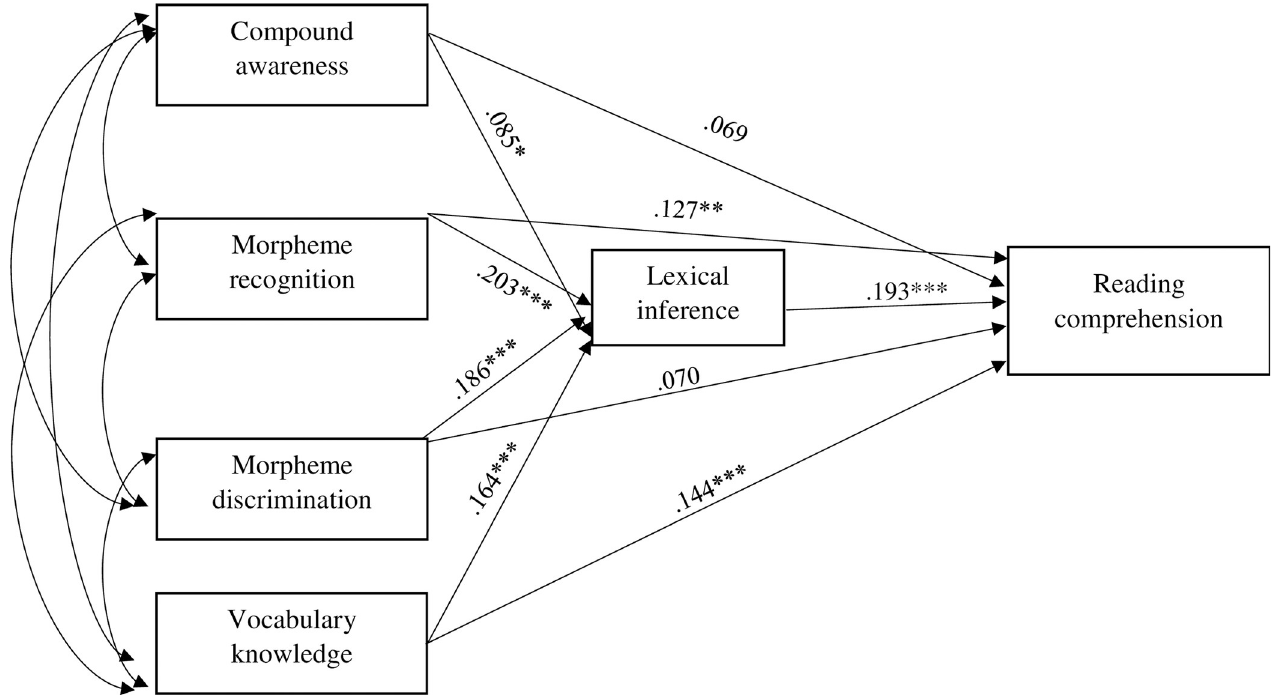
Fig 3. Model 3 showing the unidimensionality of morphological awareness and vocabulary knowledge in predicting reading comprehension via lexical inference. Note � p < .05, �� p < .01, ��� p < .001.